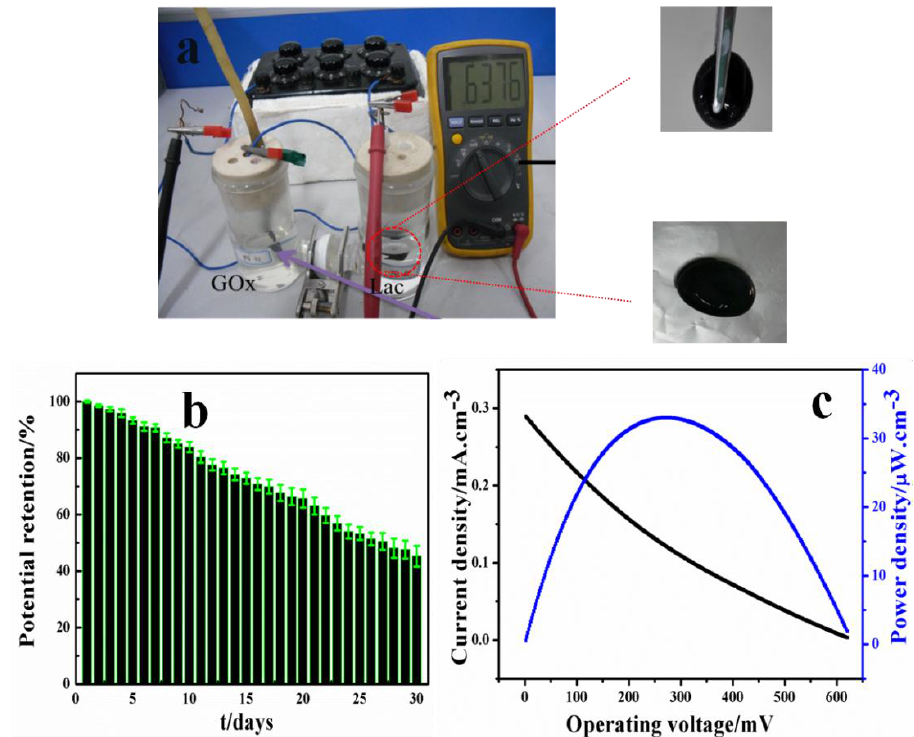
Figure 9. ( a ) The maximum open circuit voltage of the EBFCs; ( b ) The open circuit voltage from the EBFCs over 30 days; and ( c ) The power density curve of glucose/O 2 biofuel cell obtained by LSV in 0.1 m, pH 5.5, HAc/NaAc buffer containing 50 mM glucose, data were collected at 10 mV s −1 .